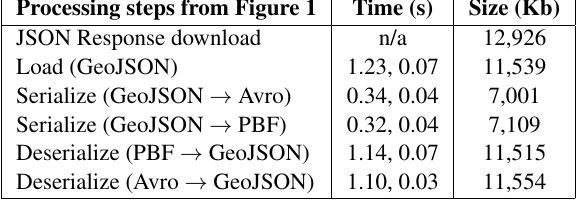
Table 2. Results of Experiment 2 using the GeoJSON file: mean and standard deviation of the time required for each processing step and size of the resulting files.